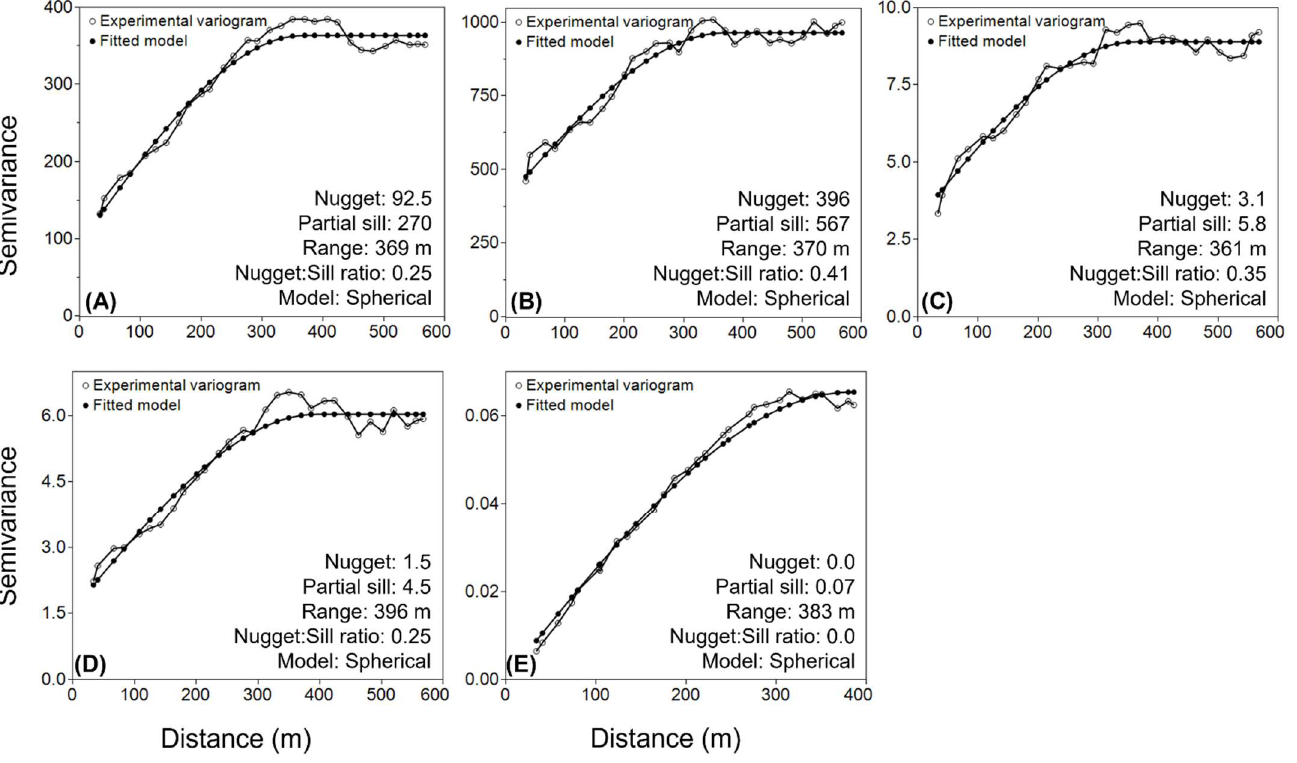
Figure 2. Experimental variogram, fitted variogram model and its parameters of, ( A ) one-day CO 2 ; ( B ) organic C; ( C ) organic N; ( D ) soil health index; and ( E ) apparent soil electrical conductivity in the study area.